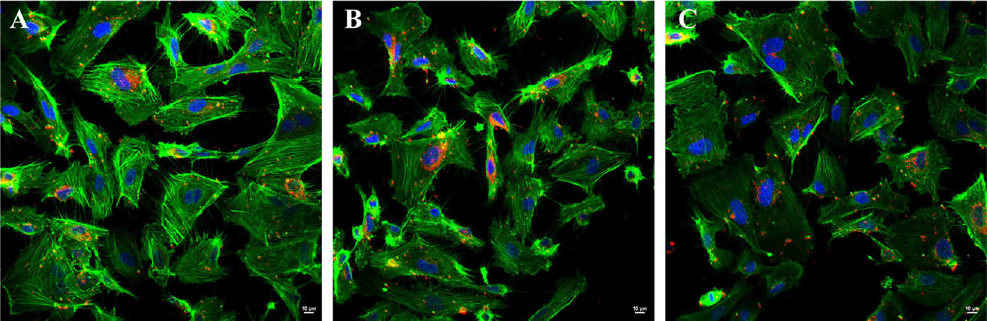
Figure 1. MPs are internalised by HUVECs. HUVECs were incubated with PKH26 labeled MPs for 2 h at 37 °C. Representative confocal microscopy images of HUVECs cytoplasm (green) and nuclei (blue) on incubation with MPs (red) obtained from normal subjects ( A ), non-splenectomised β -thalassaemia/HbE ( B ) and splenectomised β -thalassaemia/HbE patients ( C